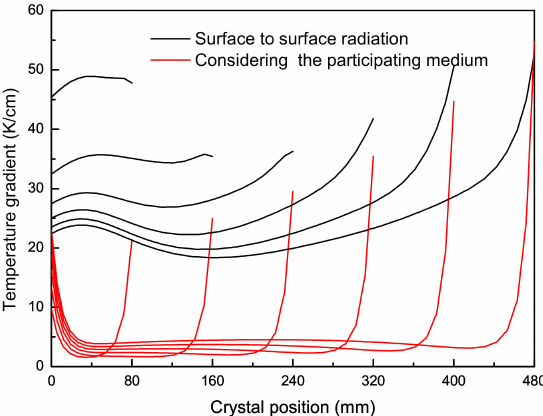
Figure 8. The crystal temperature gradient during the dynamic growth process to help us consider the participating medium and the surface to surface